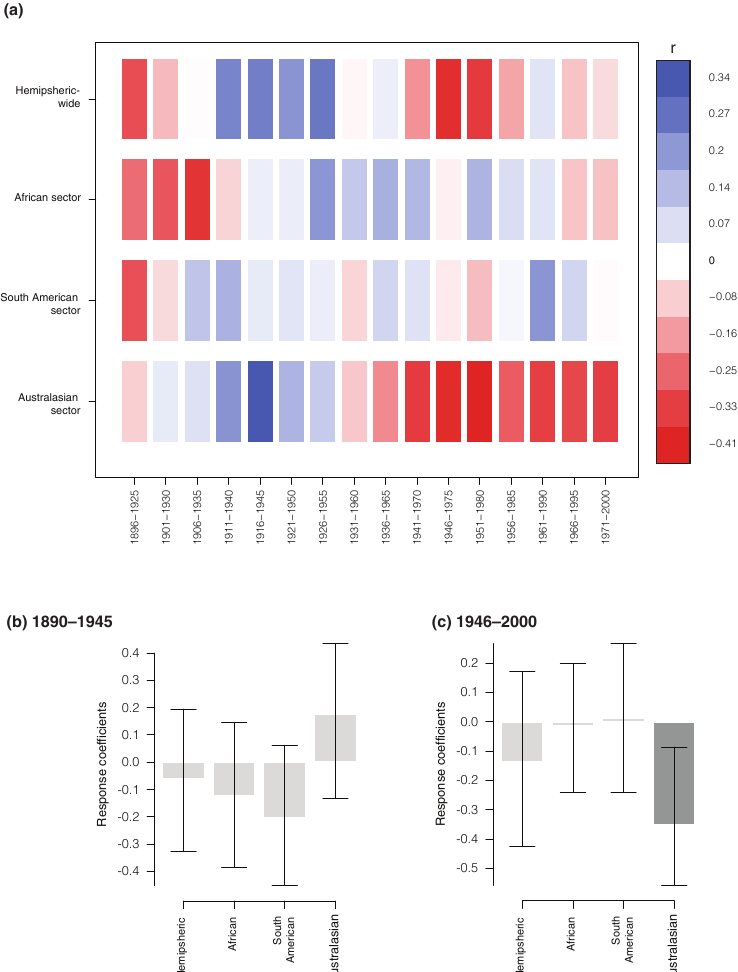
Figure 7. Changing Southern Annular Mode (SAM) relationships through the twentieth century. Running 30-year correlations (a) and bootstrap correlations (b, c) between hemispheric-wide and sector-specific SAM reconstructions (July–October) (Visbeck, 2009) and the Dracophyllum series. Bootstrap correlation periods obtained by halving the SAM dataset spanning 1890 to 2000. The dark bar indicates that only the Australasian SAM has a statistically significant correlation to the temperature-sensitive tree-ring series during the post-1940s period for the austral winter and early spring ( p < 0 .